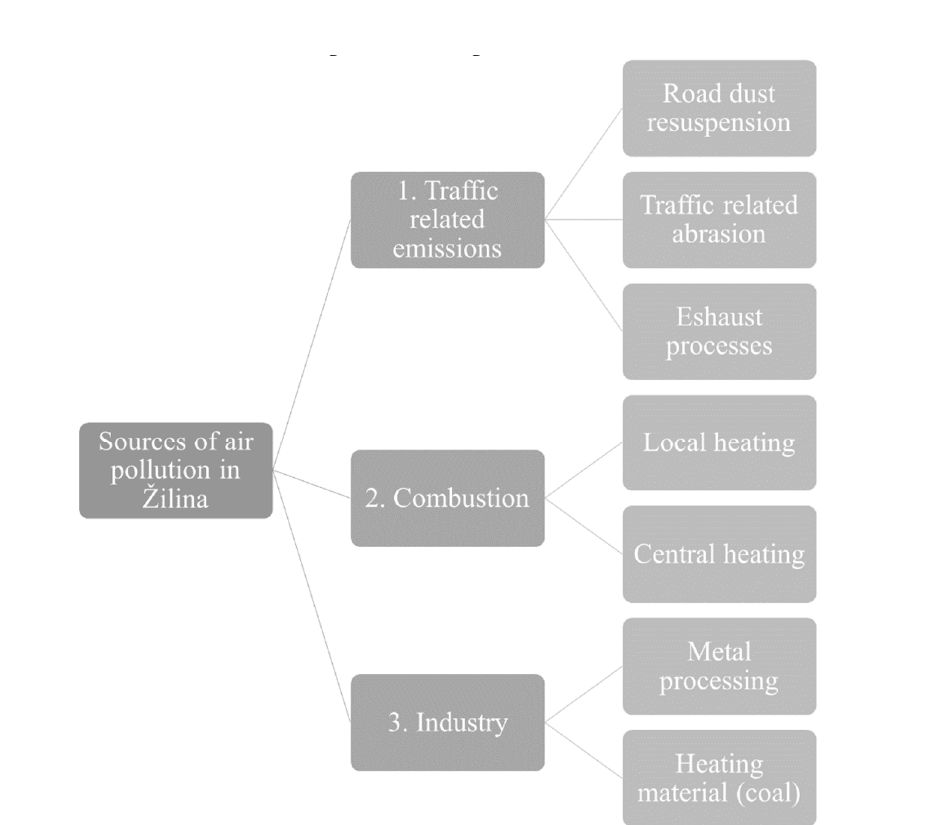
Figure 10. Assessment of potential sources of air pollution in the city of Žilina.